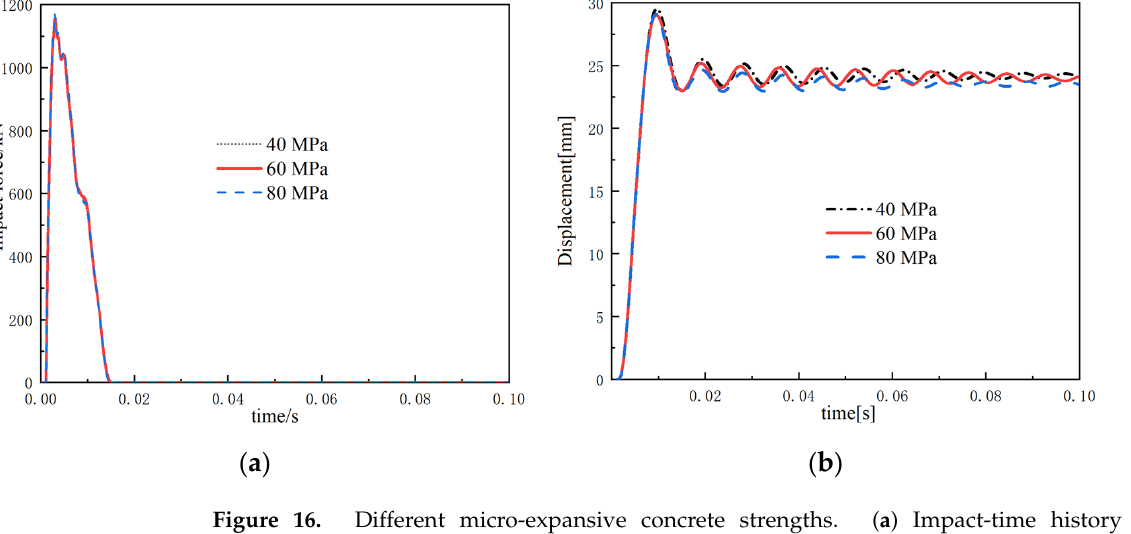
Figure 16. Different micro-expansive concrete strengths. ( a ) Impact-time history curve. ( b ) Displacement-time history curve.